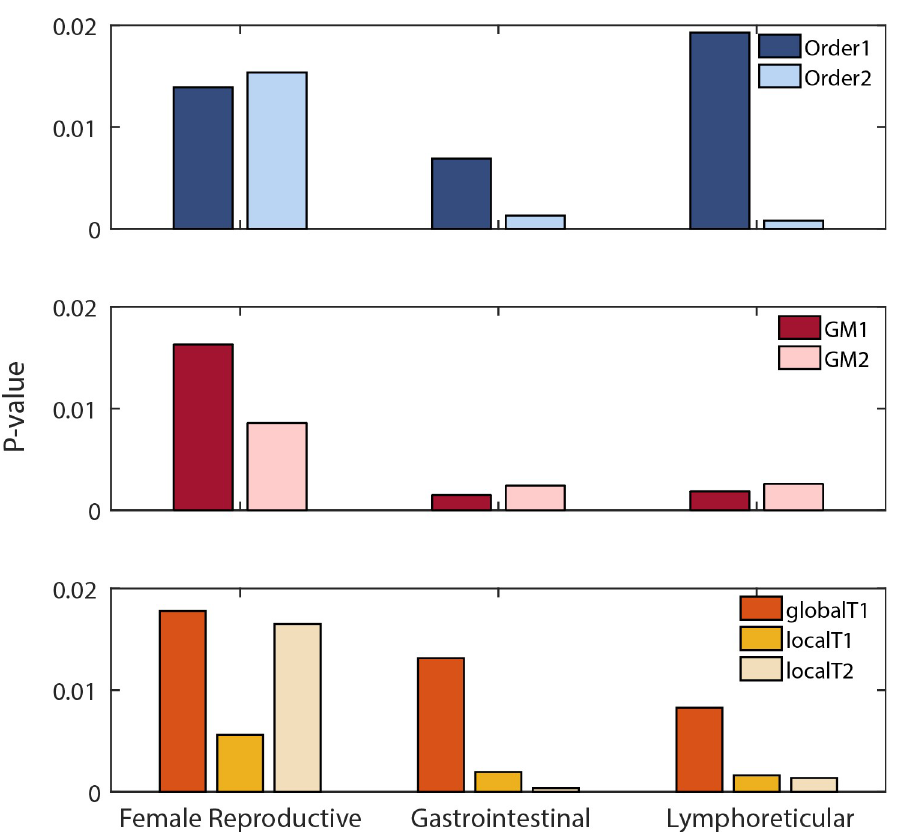
Fig 4. Preprocessing decisions influence the significance of tissue grouping at organ-system level. We compared the mean Euclidean distance observed between tissues belonging to the same organ-system to the mean Euclidean distance for 10000 randomly selected groups with the same number of tissues. The significance of the grouping (P- value) is computed as the proportion of random distances lower than the observed distance for each